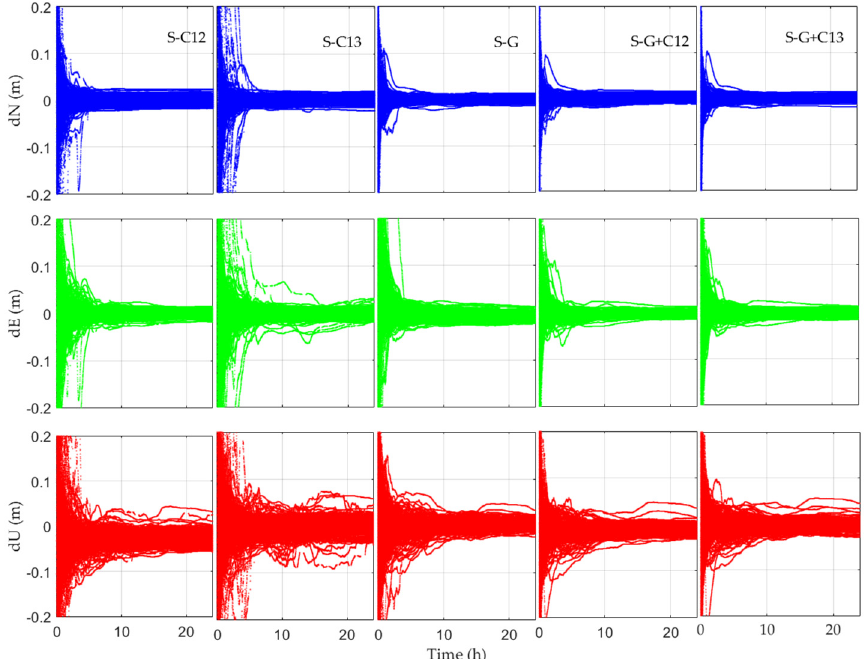
Figure 5. Static PPP error series for 20 days at 17 stations utilizing GBM’s precise orbit/clock corrections (the result after the abnormal data are raised).